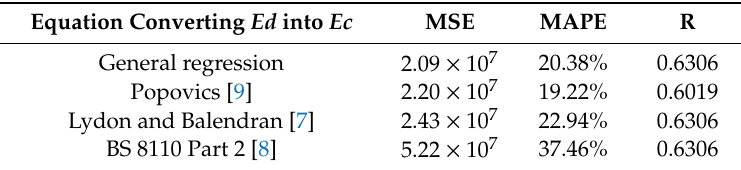
Table 4. Correlation analysis for predicted and measured Ec values obtained using the proposed equations and the general regression equation.